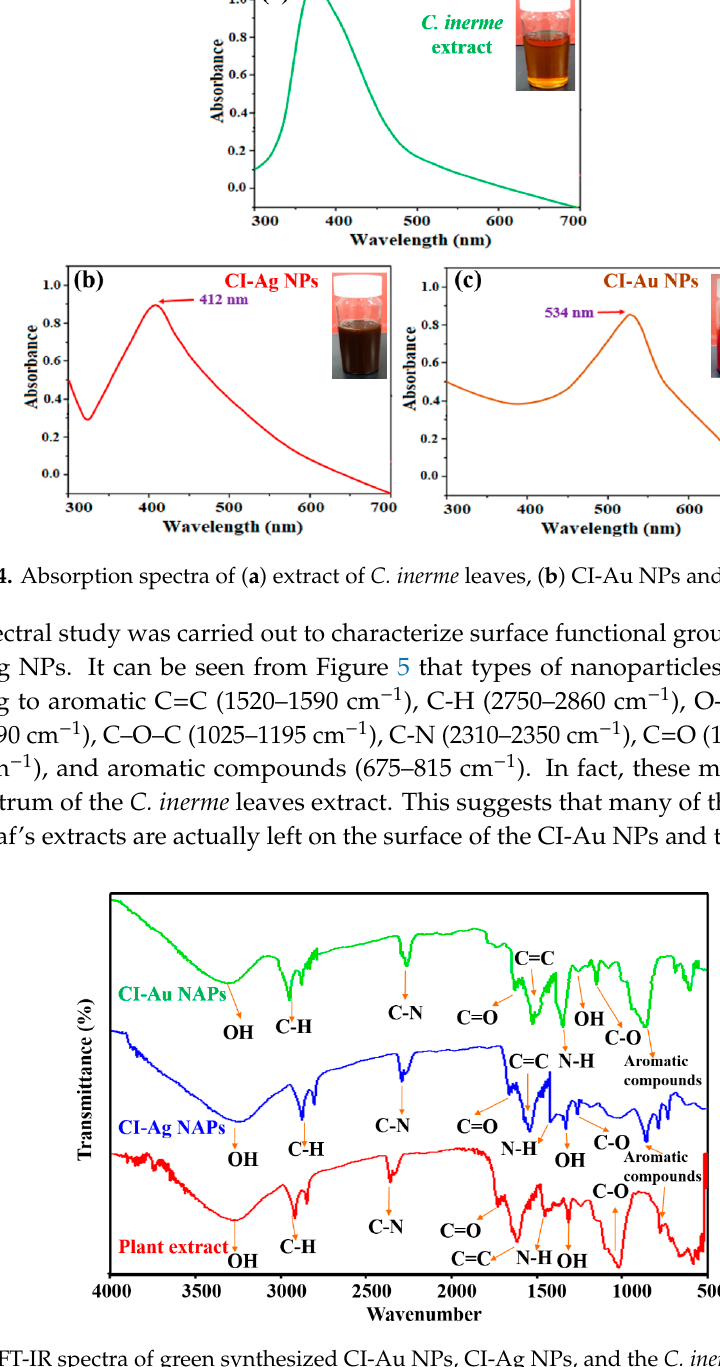
Figure 5. FT-IR spectra of green synthesized CI-Au NPs, CI-Ag NPs, and the C. inerme leaves extract.